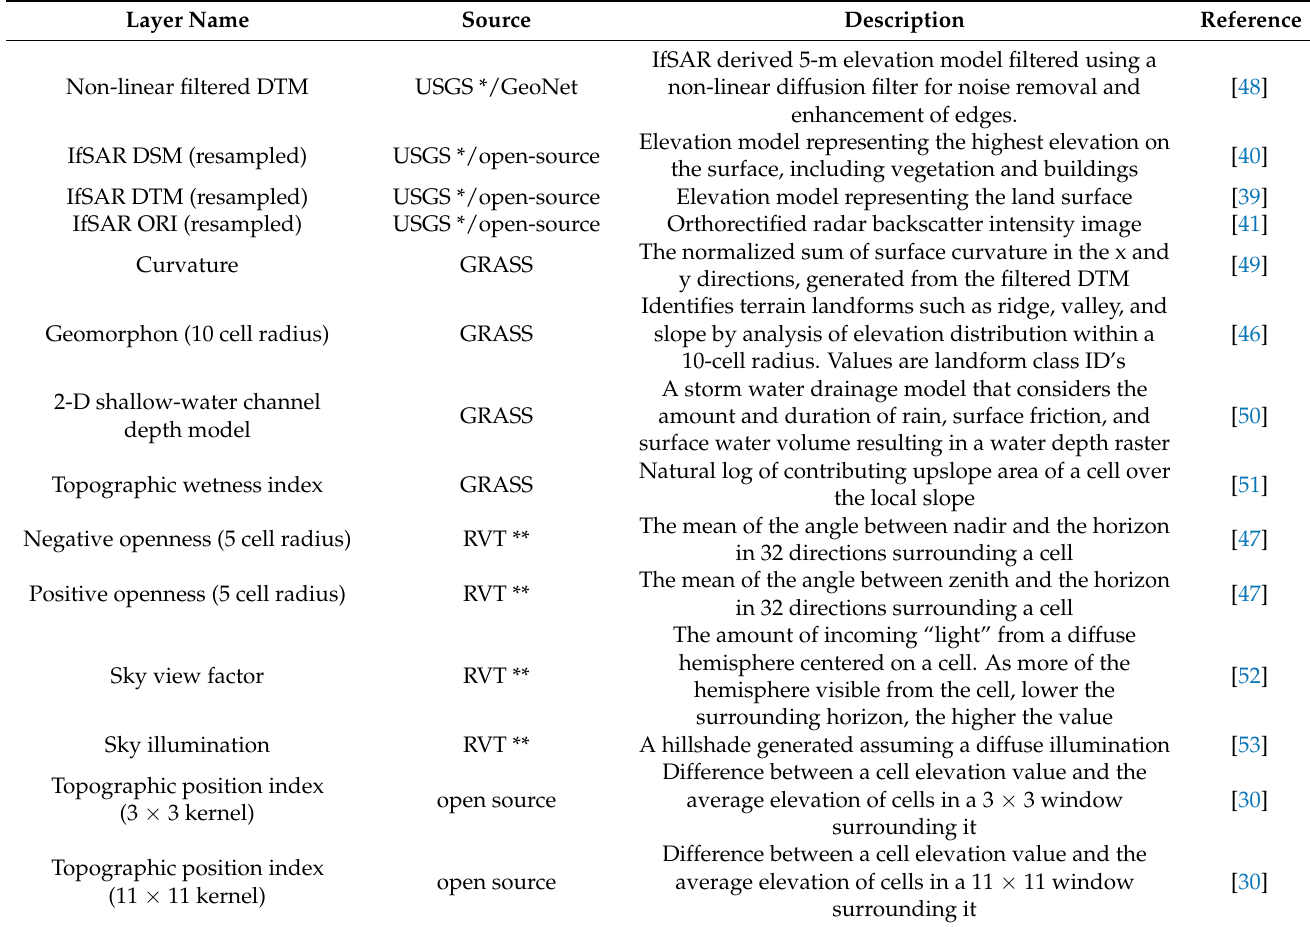
Table 1. Source and description of layers used as inputs for the U-net model. DTM- Digital Terrain Model, DSM- Digital Surface Model, ORI- Orthorectified Radar Image, IfSAR- Interferometric Synthetic Aperture